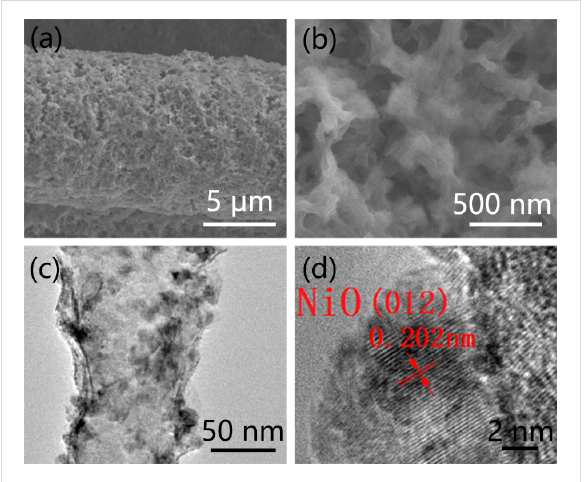
Figure 5: SEM images of (a) CC-CNT@NiO; (b) magnified CC-CNT@NiO. (c) TEM image of NiO particles on CNT; (d) high-reso- lution TEM image of NiO.